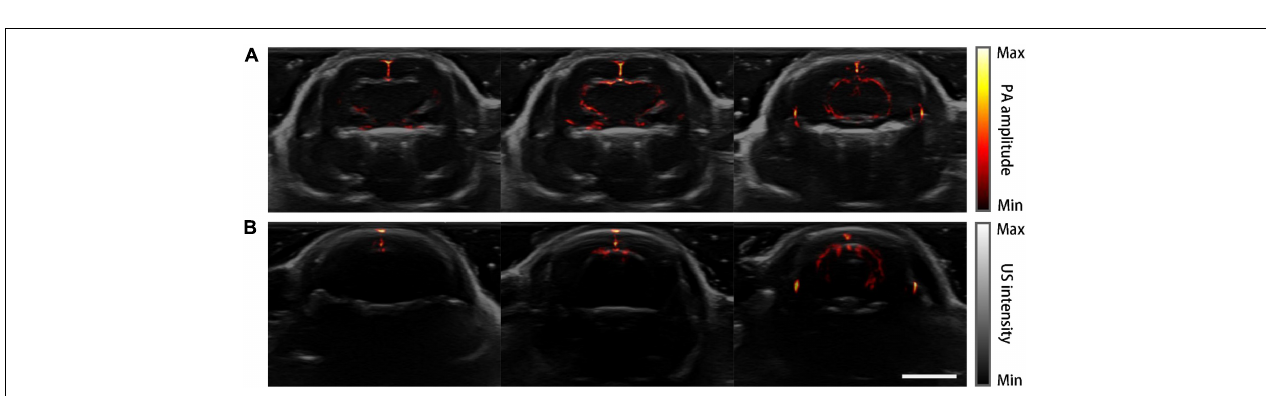
FIGURE 5 | USI imaging results. (A) Gray-scale images of a normal mouse, from left to right are plane (a–c) which are shown in Figure 2B . (B) Gray-scale images of the mouse model imaged at the same planes as in (A) . (C) Doppler images of the normal mouse. Gray-scale images are displayed on the left. Two different layers are shown in the top and bottom rows. (D) Doppler images of the mouse model at the same planes of (C) . Scale bar = 5 mm.